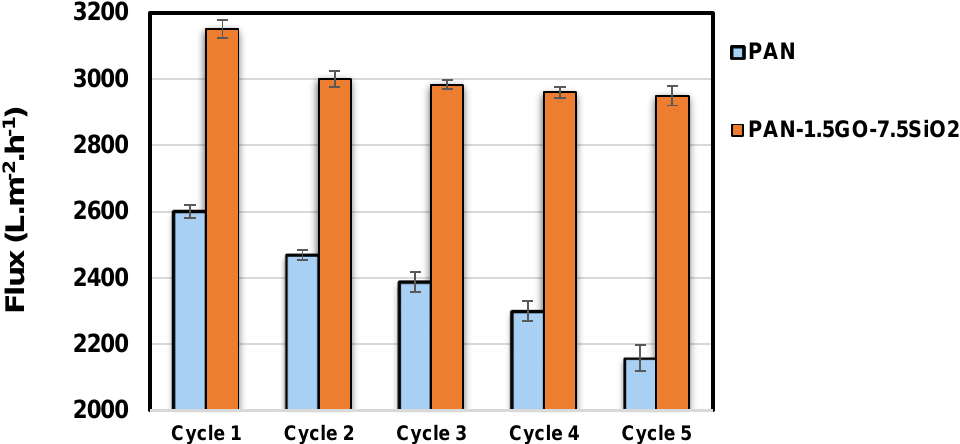
Figure 7. Flux for the permeate of pristine PAN membrane and PAN-1.5GO-7.5SiO 2 hybrid membrane for 5 consecutive cycles.